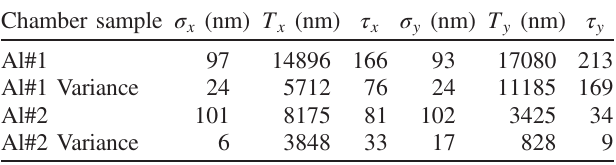
TABLE I. Measured surface roughness parameters, for x and y direction. For the y -direction, the numbers correspond to an analysis of the surface residuals after subtraction of a cubic polynomial. The averages and variances are computed from the results for 6 image scans for sample #1, and 18 image scans for sample #2.